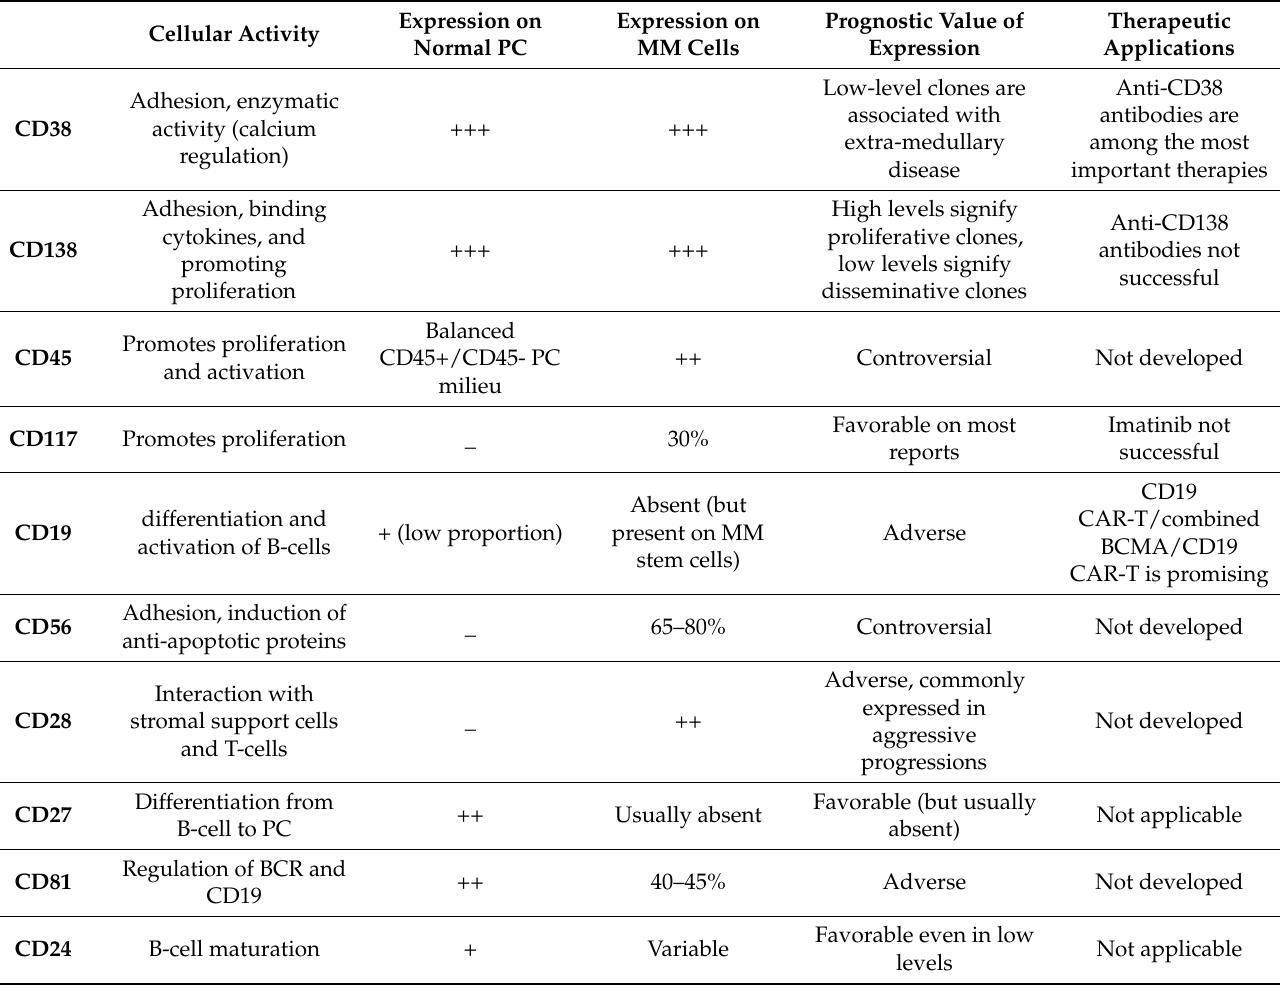
Table 1. Selected key surface antigens on MM cells